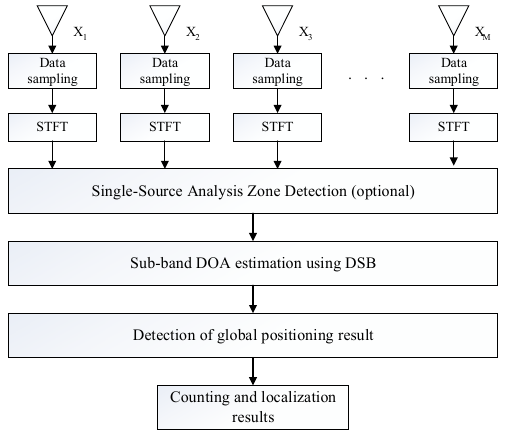
Figure 2. Flow chart of counting and localization of sound sources.